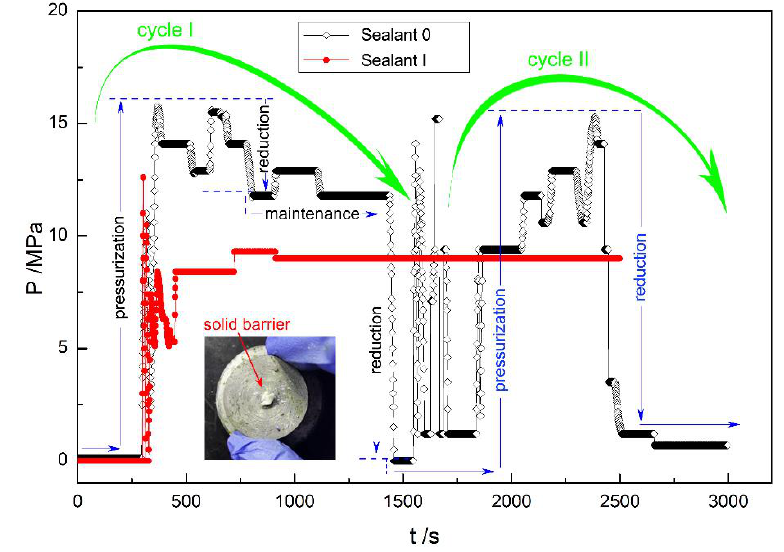
Figure 6. Comparison of the dynamic sealing processes of Sealant 0 and Sealant I in a 0.5 mm × 1.0 mm × 10 mm crack defect. The inset is an image of the solid barrier through the leak